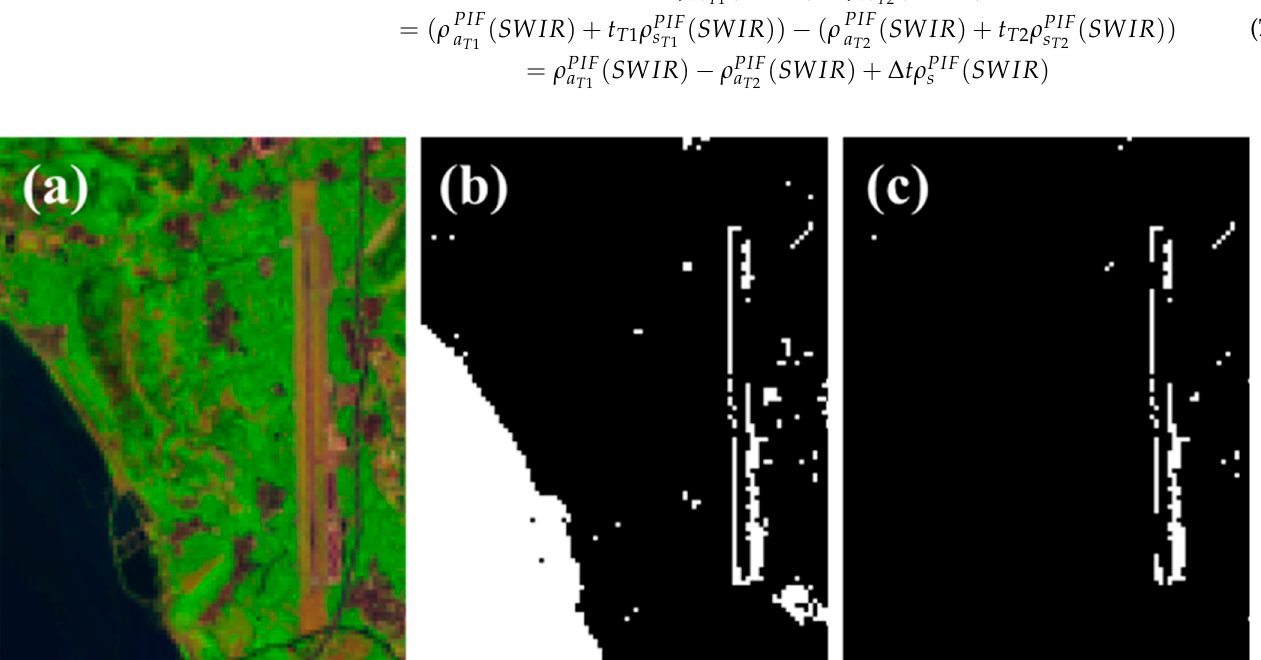
Figure 6. Histogram of D BPI (blue bar) and D PIF (yellow bar) derived by two date images (Dates: 11 May 2017 and 27 May 2017) in Lake Taihu, China. 2.3.2. Other Atmospheric Correction Algorithms The SeaDAS-SWIR Algorithm For turbid waters, the “black pixel” assumption in NIR bands is invalid because of the contribution of phytoplankton, detritus, and suspended sediment to water backsca tt er [2,10]. Research from Hale et al. (1973) indicated that the water in SWIR bands has stronger absorption than that in NIR bands [30], and the turbid water in the former meets the re- quirement of the “black pixel” assumption [13]. Therefore, Wang and Shi (2005) [10]